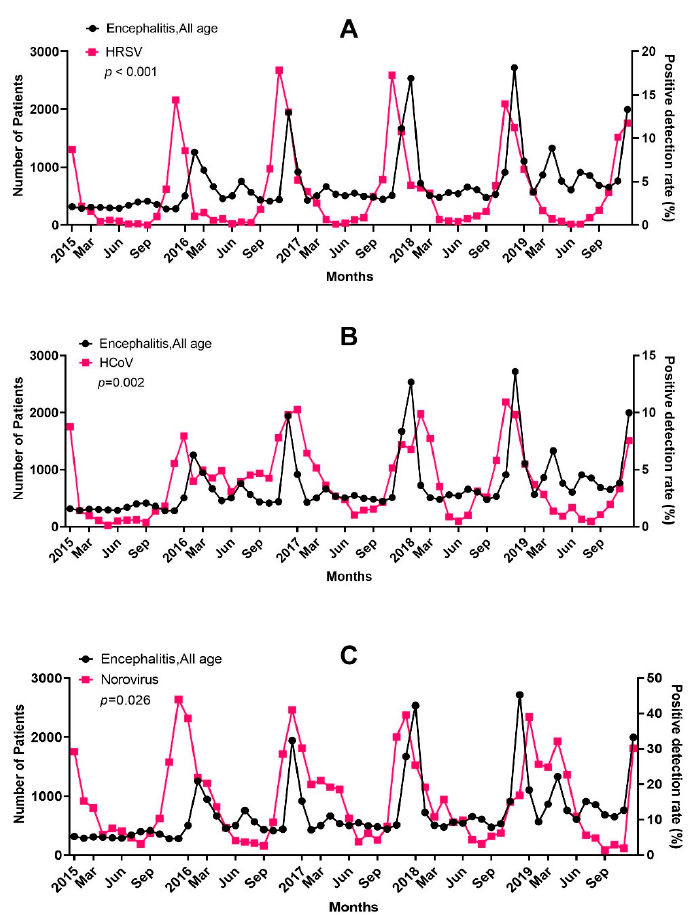
Figure 3. Relationship between the positive detection rate (PDR) of ( A ) respiratory syncytial